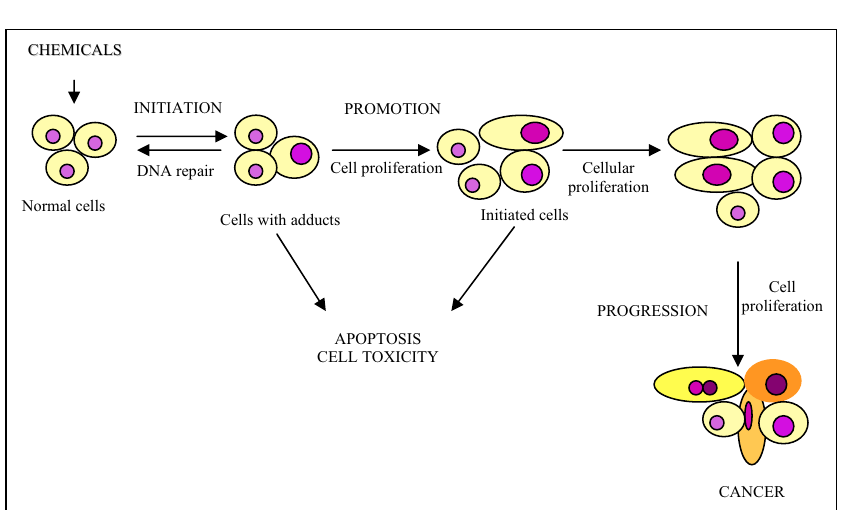
Fig. 2 – Chemical carcinogenesis stages and the occurrences involved in each